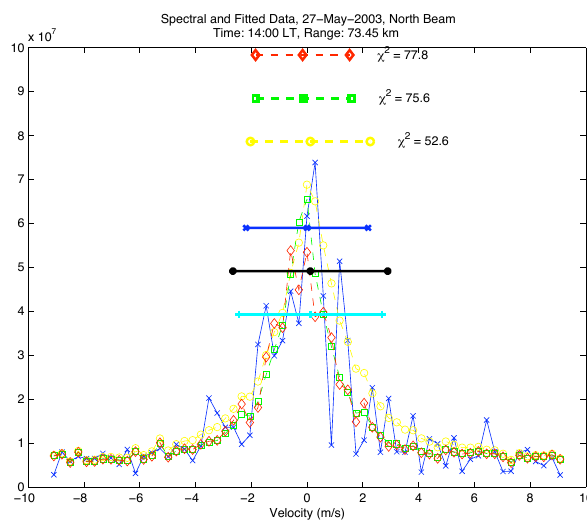
Fig. 2. Example spectrum (blue) overlaid with yellow, green, and red symbols corresponding to three different fitting procedures de- scribed in the text. Spectral width estimates obtained with six dif- ferent methods are shown as horizontal lines (with matching colors to the diamonds). The green and red data points indicate spectral widths obtained from logarithmic fits applied with spectral models (4) and (5) result in comparable widths shown in green and red, respectively. Spectral moment calculation (blue) and linear gener- alized Gaussian fit (yellow) give slightly wider estimates. Estimates obtained from the correlation times, with (black) and without (cyan) accounting for triangular weights are the largest for this spectrum.